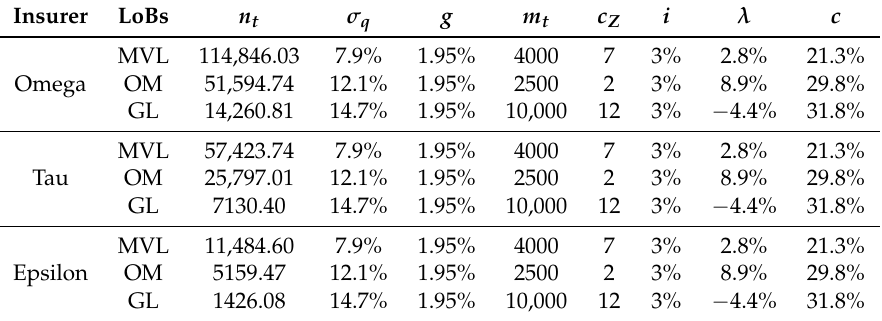
Table 3. Parameter for Collective Risk Model (CRM) analysis of Premium